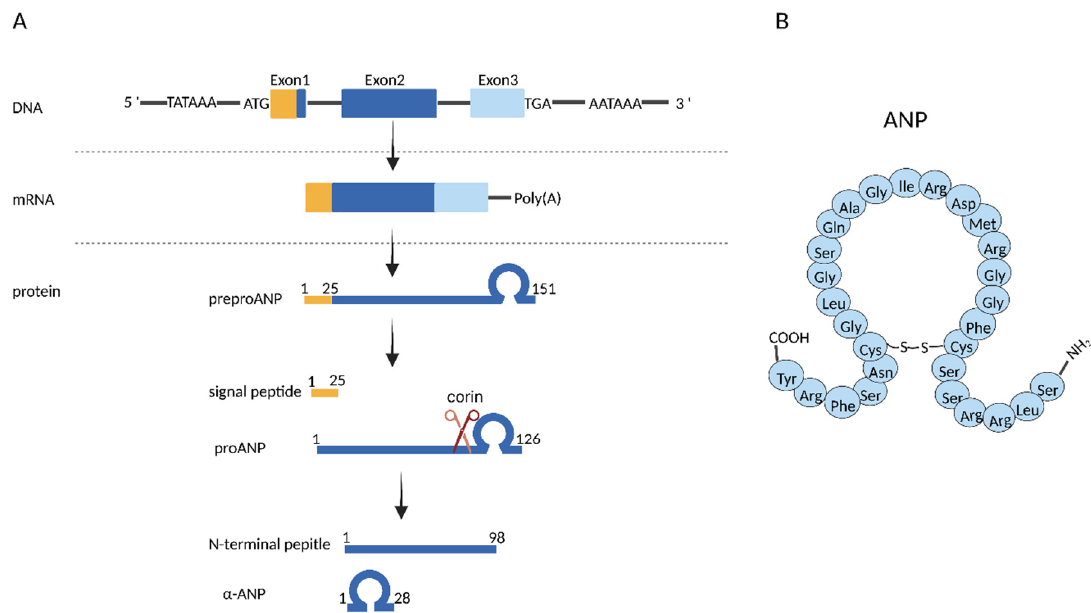
Figure 1. Schematic representation of human atrial natriuretic peptide gene structure and biosynthetic process. ( A ) biosynthetic process of ANPs. ( B ) primary structure of ANPs.